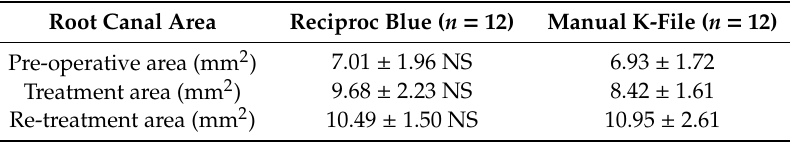
Table 1. Pre-operative root canal area (mean ± standard deviation (SD); mm 2 ), after root treatment and after secondary root treatment. No statistical di ff erences were observed. NS = no significant di ff erences between groups ( p > 0.05).